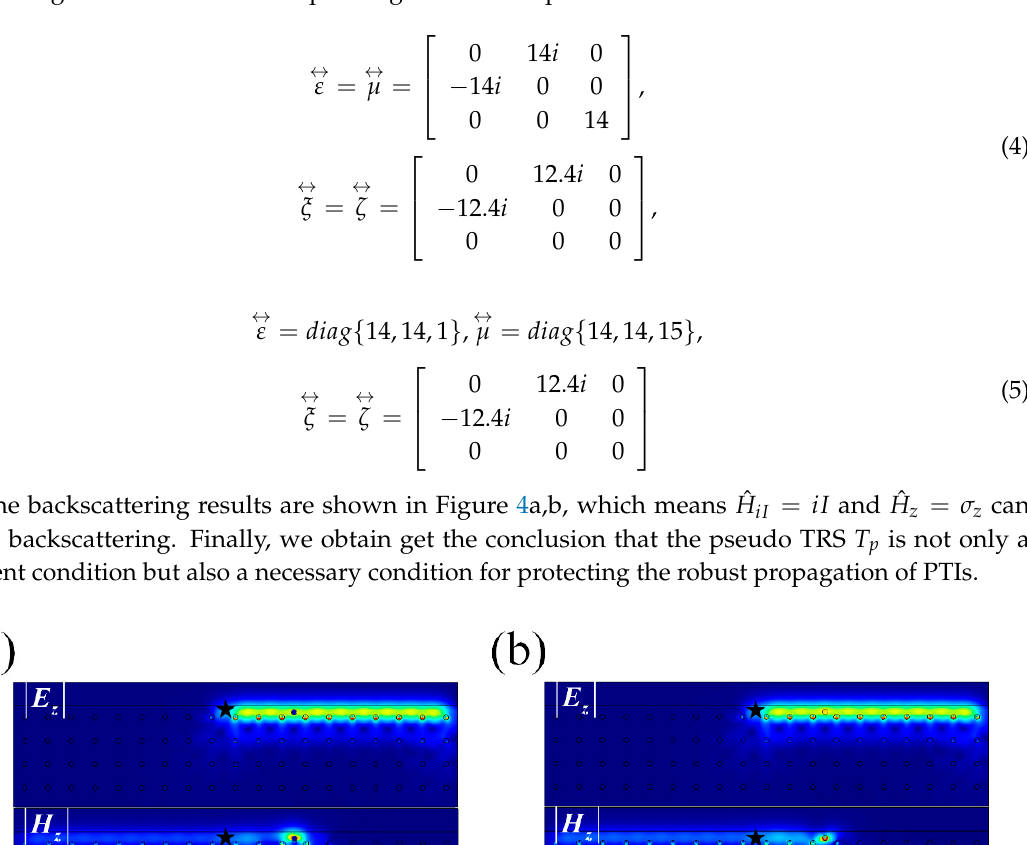
ˆ H iI + ix and ( b ) z + ix . It can 𝐻(cid:3553) 𝐻(cid:3553) (cid:3036)(cid:3010)(cid:2878)(cid:3036)(cid:3051) and ( b ) (cid:3053)(cid:2878)(cid:3036)(cid:3051) . It can